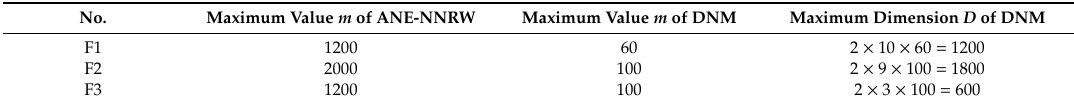
Table 4. Set value of m in the experiment.